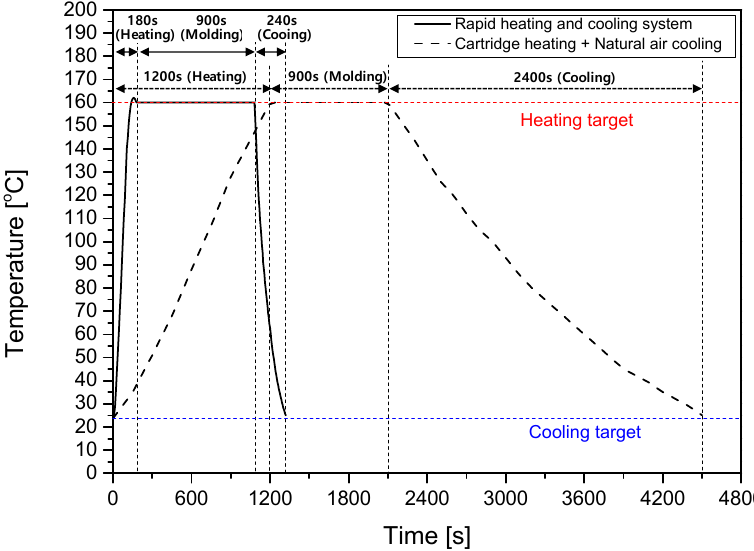
Figure 18. Heating and cooling graphs for two systems. Table 8. Comparison of heating time (to 160 °C) and cooling time (to 25 °C).